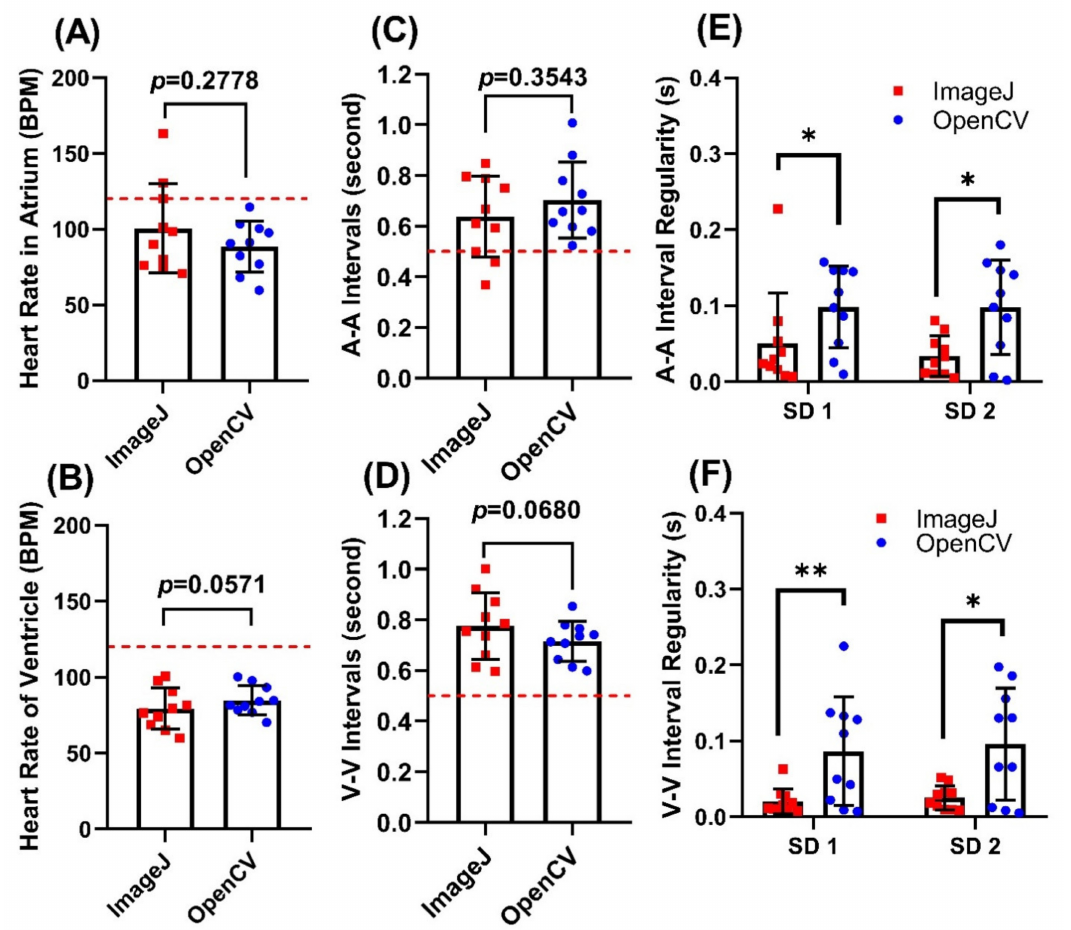
Figure 6. Comparison of heart rate and cardiac rhythm measurement in 500 ppm Camphor-treated zebrafish embryos aged at 72 hpf using either OpenCV or ImageJ methods. Comparison of heart rate obtained from either atrium ( A ) or ventricle ( B ) chambers using ImageJ TSA and OpenCV methods. Comparison of atrium to atrium (A-A) ( C ) and ventricle to ventricle (V-V) ( D ) intervals using ImageJ and OpenCV methods. Comparison of heartbeat regularity in either atrium ( E ) or ventricle ( F ) using either ImageJ or OpenCV methods, red dotted line signified normal value of each parameter obtained from control group. Data was calculated using t -test ( A , B ) and Wilcoxon test ( C – F ), and presented as Mean ± SD, n = 10 (* p < 0.05; ** p <